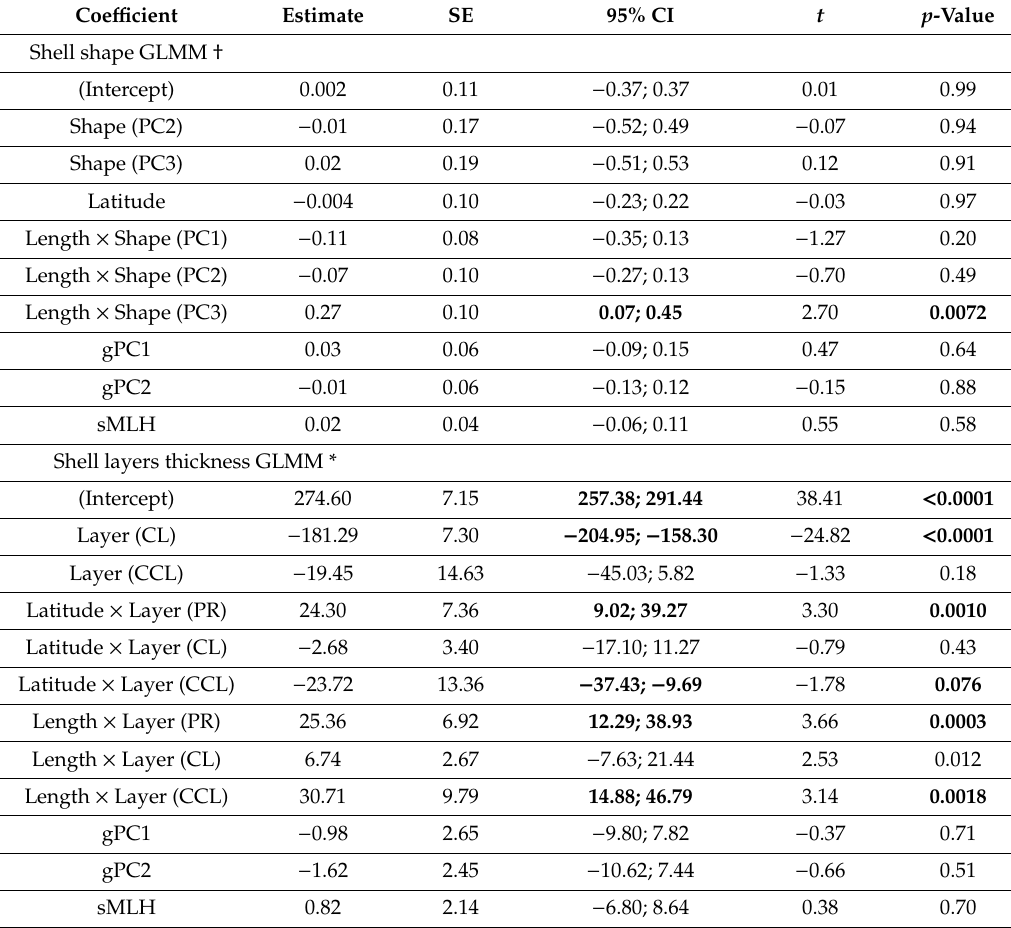
Table 2. Summary of the results of GLMMs of shell shape and shell layer thickness. Estimated statistics and bootstrapped 95% confidence intervals (CIs) for regression parameters are reported for the modelled relationships described in Equations (1) and (2) in the Materials and methods. Because both shell shape and layer were analyzed as categorical variables, shape PC1 and the PR layer were used as the reference levels in the respective models. Regression parameters were considered statistically significant and highlighted in bold when the bootstrapped 95% CI did not overlap